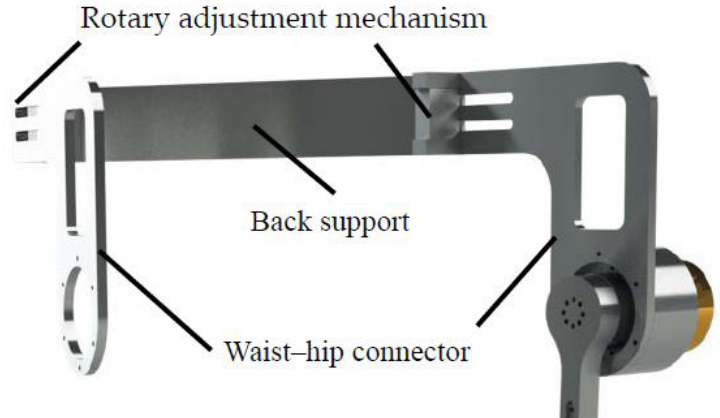
Figure 4. Waist design of the LLRE-II.